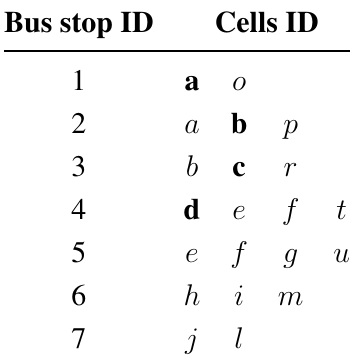
Table 2. Example of the mapping from the bus line (sequence of bus stops) to the cells covering each bus